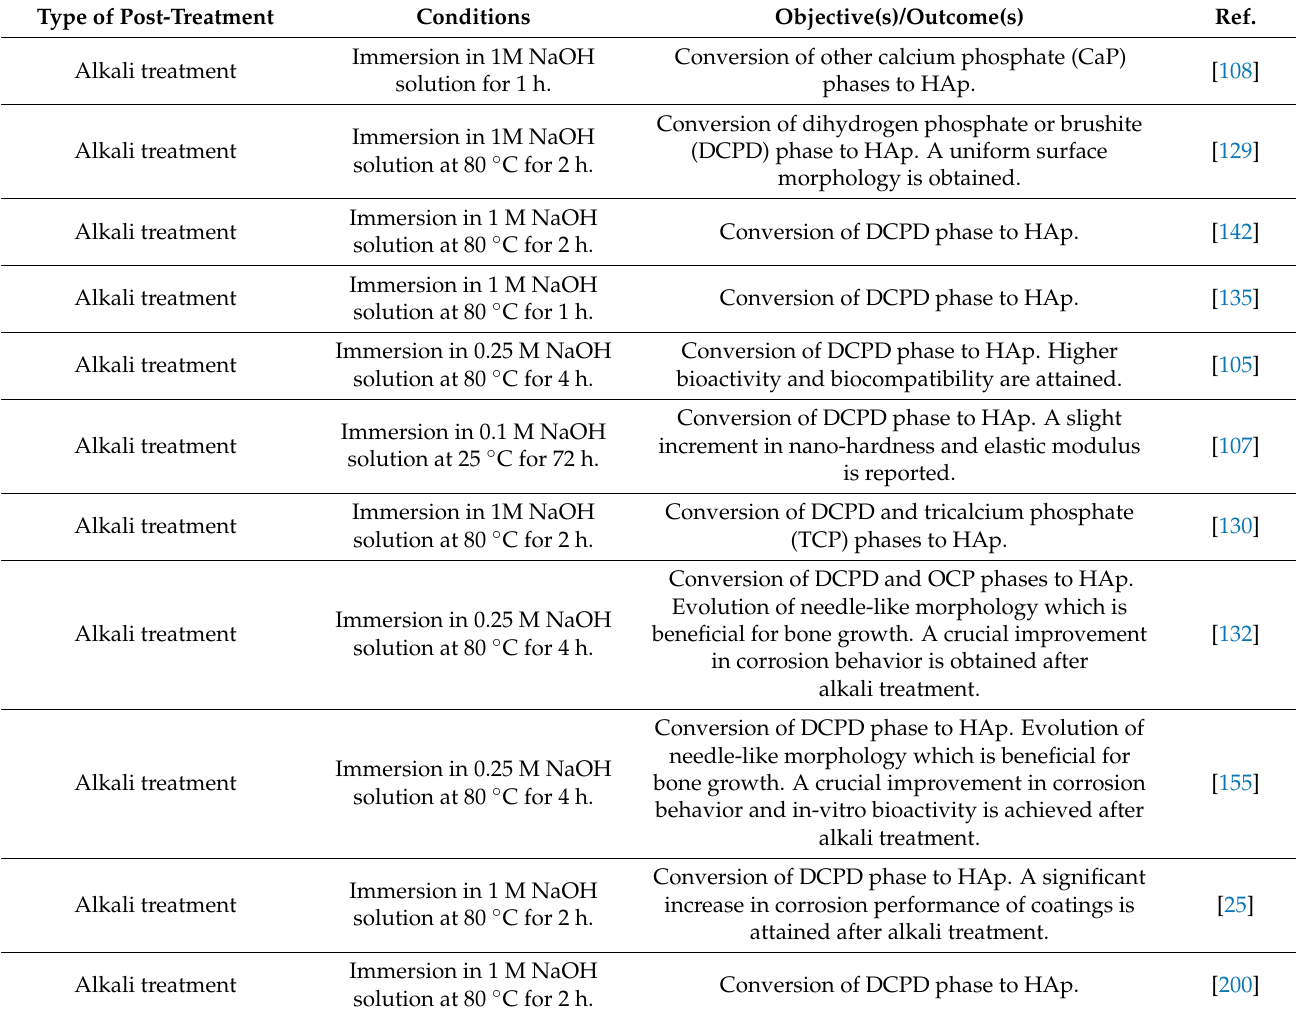
Table 7. The various types of post-treatments, process conditions and major objectives/outcomes. Type of